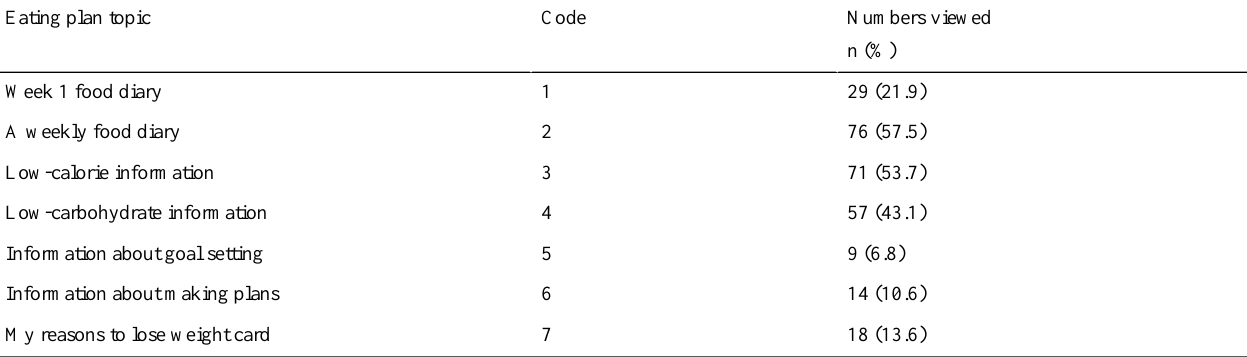
Table 5. Numbers (and percentages) of participants who reused the eating plan